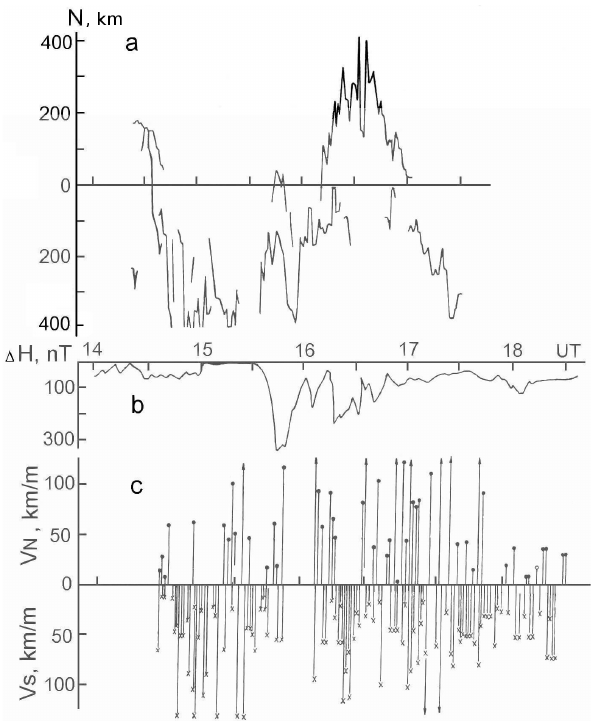
Figure 23. Development of an auroral substorm over Cape Chelyuskin on 17 December 1965: (a) dynamics of the auroral forms, (b) variation of the geomagnetic H component, and (c) mag- nitude and direction of the auroras’ velocity, where the arrows show velocities beyond threshold (Starkov and Feldstein,